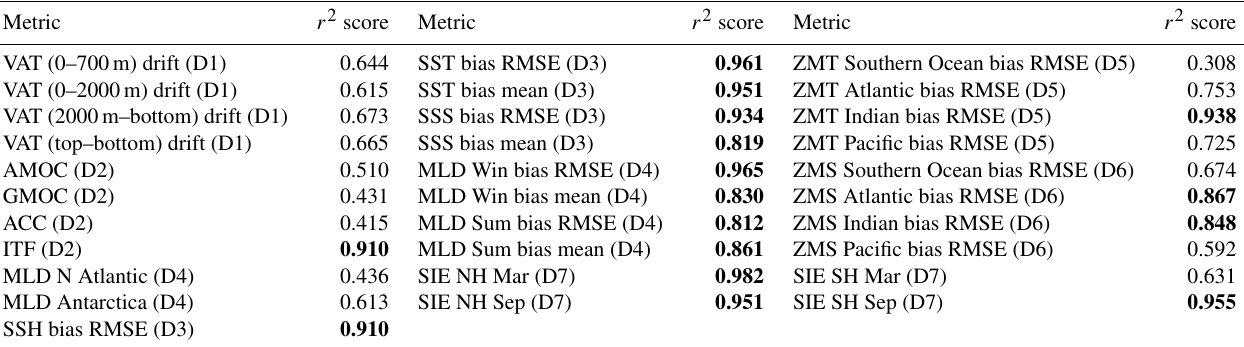
Table 3. The r 2 scores of linear fits for model scatters between OMIP-1 and OMIP-2 simulations in some globally integrated/averaged quantities and circulation metrics. High r 2 scores ( > 0 . 8) are emphasized with bold numbers. The symbol in the parentheses after each metric indicates the table number in Appendix D (Tables D1–D7) listing specific values from individual models. See the caption of that table for the explanation about the